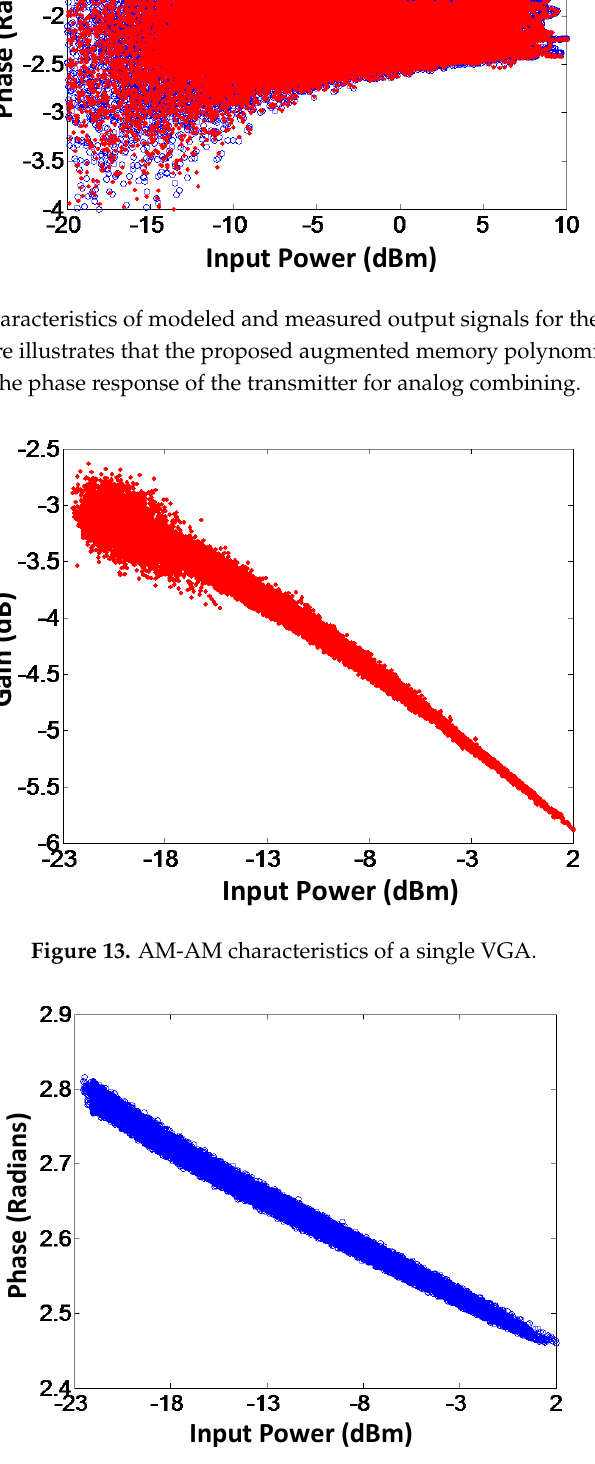
Figure 14. AM-PM characteristics of a single VGA.